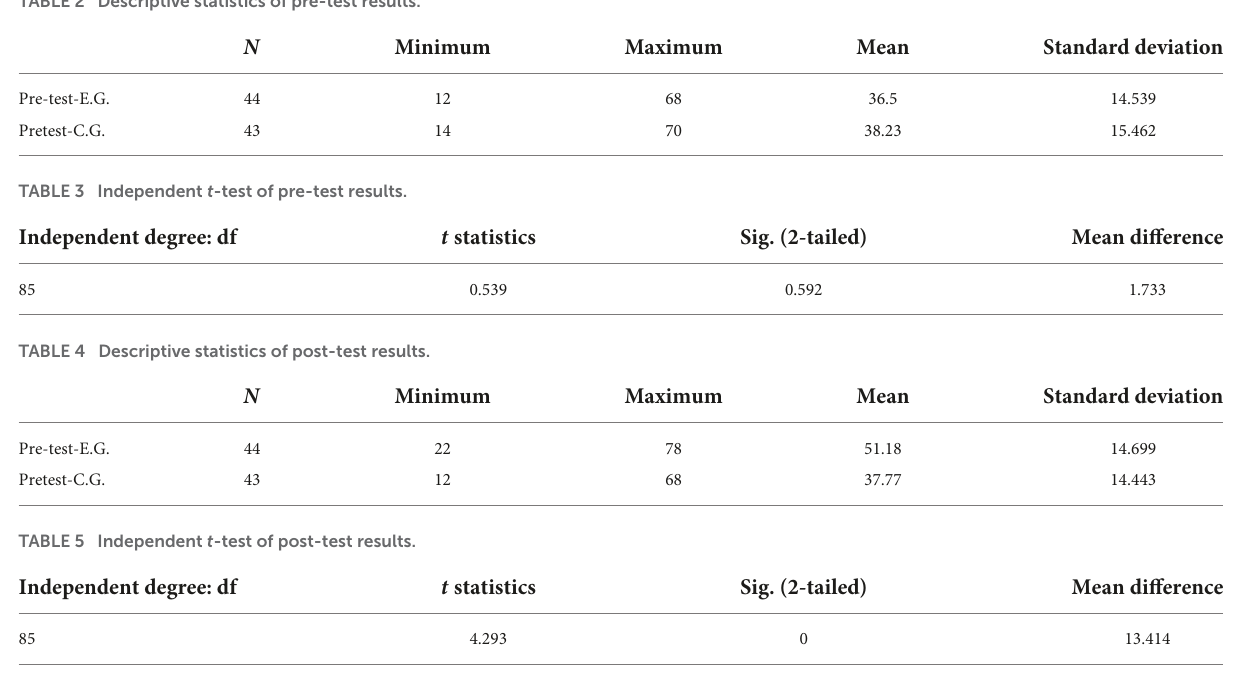
TABLE 2 Descriptive statistics of pre-test results.